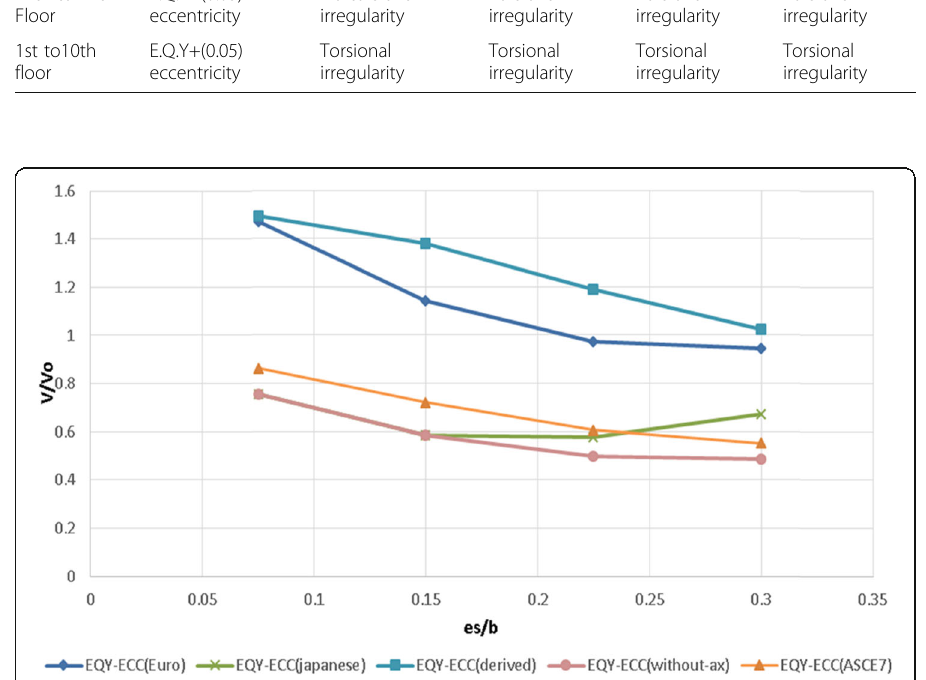
Fig. 42 Comparison of eccentricity ratio — design force ratio (design force in un-symmetric model V o , normalized by design force in symmetric plan V ) for stiff side elements for ASCE 7-16, EC-8, Japanese, derived equation, and without considering torsional irregularity